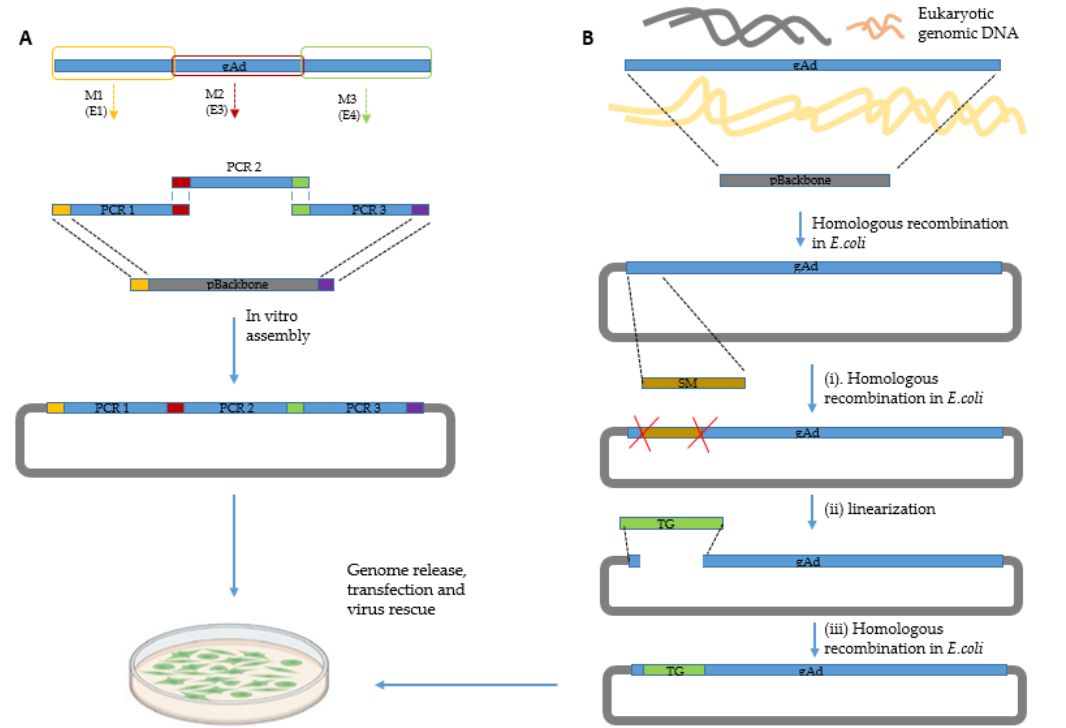
Figure 2. Cloning and rescue of recombinant adenoviral vectors. ( A ) Modular assembly of adenovirus genomes. Modifications need to be introduced into individual modular, before the final assem- bly. The figure above shows the modification of adenovirus eerily gene region (E1, E2 and E3). ( B ) Direct cloning of complete adenovirus genomes from purified virions or infected cells and further modification of adenovirus genomes by homologous recombination. For the adenovirus genome engineering, ampicillin-mediated positive selection is used insert the selection marker cassette (SM, ccdB-Amp) in the first step (i). Then, the counter-selection marker containing adenovirus plasmids are treated with restriction enzymes to linearize the plasmid (ii). Finally the linearized adenovirus genome containing plasmid, and the insert flanked by homologous arms to the target region of the adenoviral genome are co-electroporated into the E. coli strain GB05-dir, in which the RecET recom- binase is induced with L arabinose to express, enabling linear-linear homologous recombination to replace the ccdB-Amp cassette with aimed insert. Afterwards, the recombinant adenoviral vector can be reconstituted by transfection of the linearized plasmid into the producer cell line (such as HEK 293 cells) for further applications. Created partly with Biorender.com.